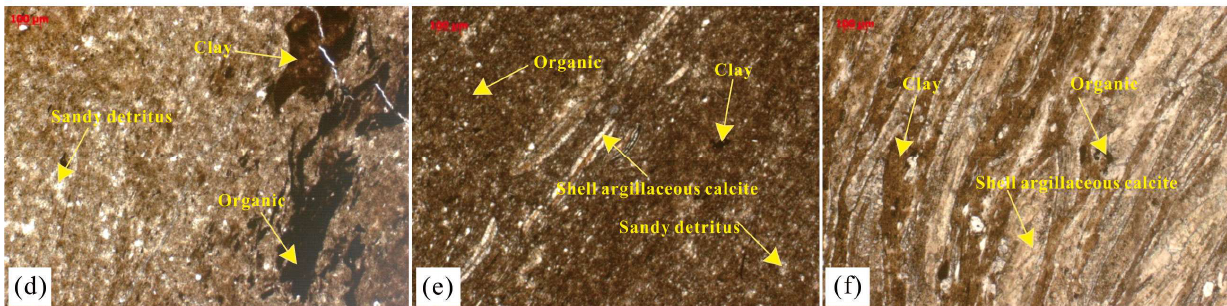
Figure 4. Microscopic photos of continental shale: ( a ) High-carbon clayey shale. ( b ) Medium-carbon calcareous clayey shale. ( c ) Medium-carbon clayey shale. ( d ) Medium-carbon clayey shale. ( e ) Me-